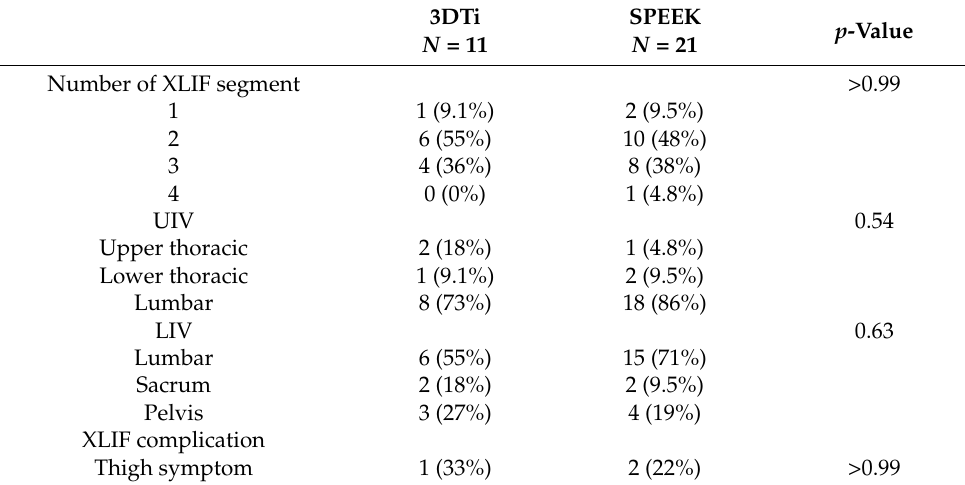
Table 2. Surgical summary.